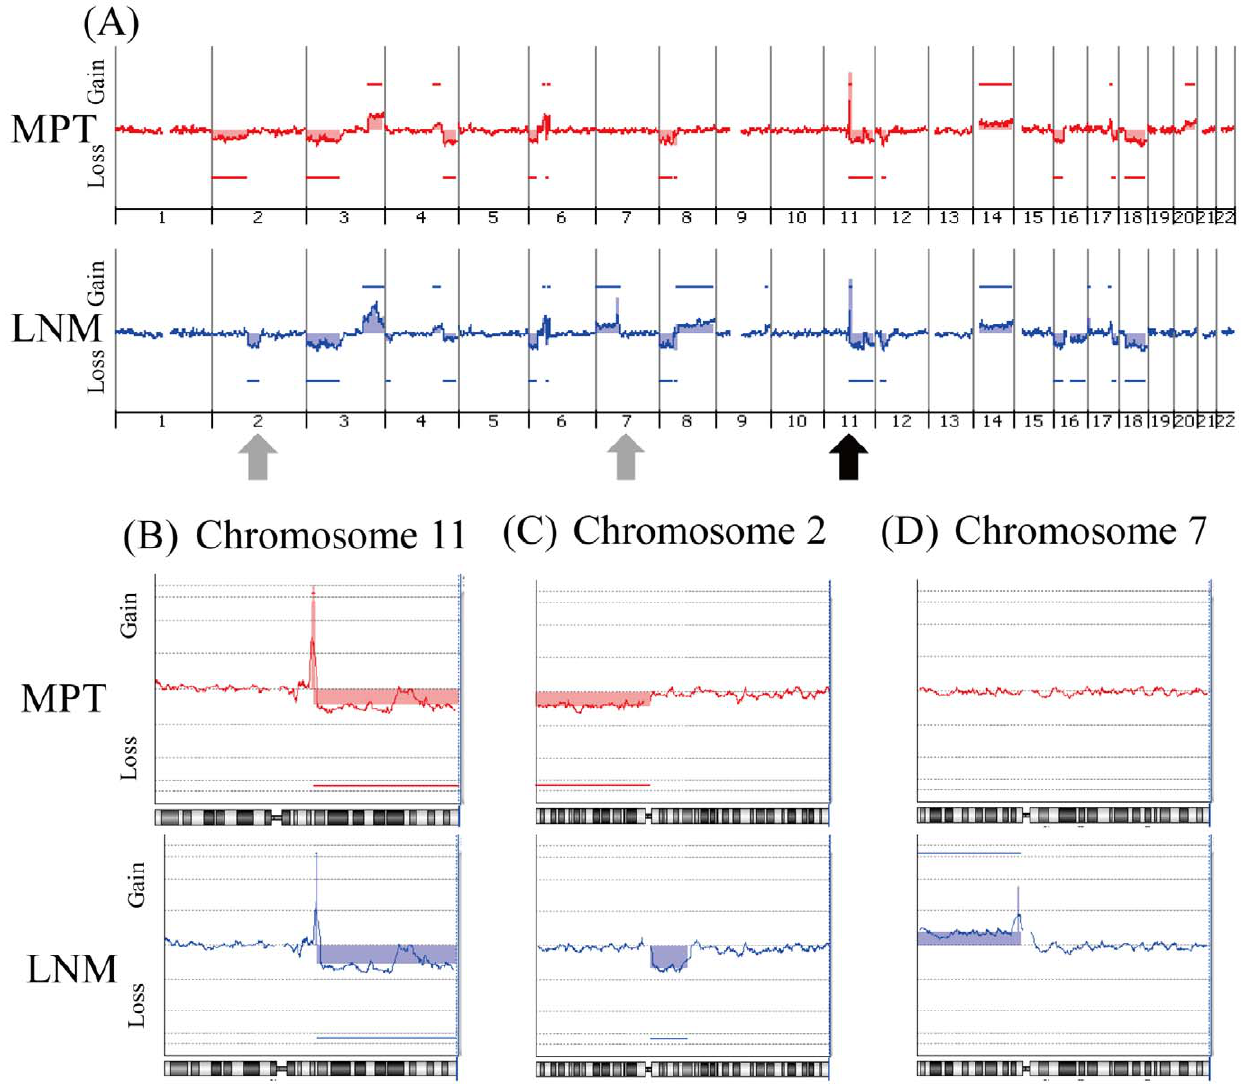
Figure 2. Representative genomic profile of a MPT and the corresponding paired LNM of a metastatic OSCC. Whole genomic profiles of the paired samples of MPT (above) and LNM (below) from case 8 are shown in (A). Detailed genomic profiles of Chr11 indicated by a black arrow in (A), and Chr2 and Chr7 indicated by gray arrows in (A) are shown in (B), (C) and (D), respectively. Horizontal lines above the center represent regions of gain, and those below the center represent regions of loss. Both MPT and LNM show similar genomic patterns in chromosome 11q (B). However, loss of 2p is detected only in the MPT (C), and loss of 2q and gain of 7p are detected only in the LNM (C and D).